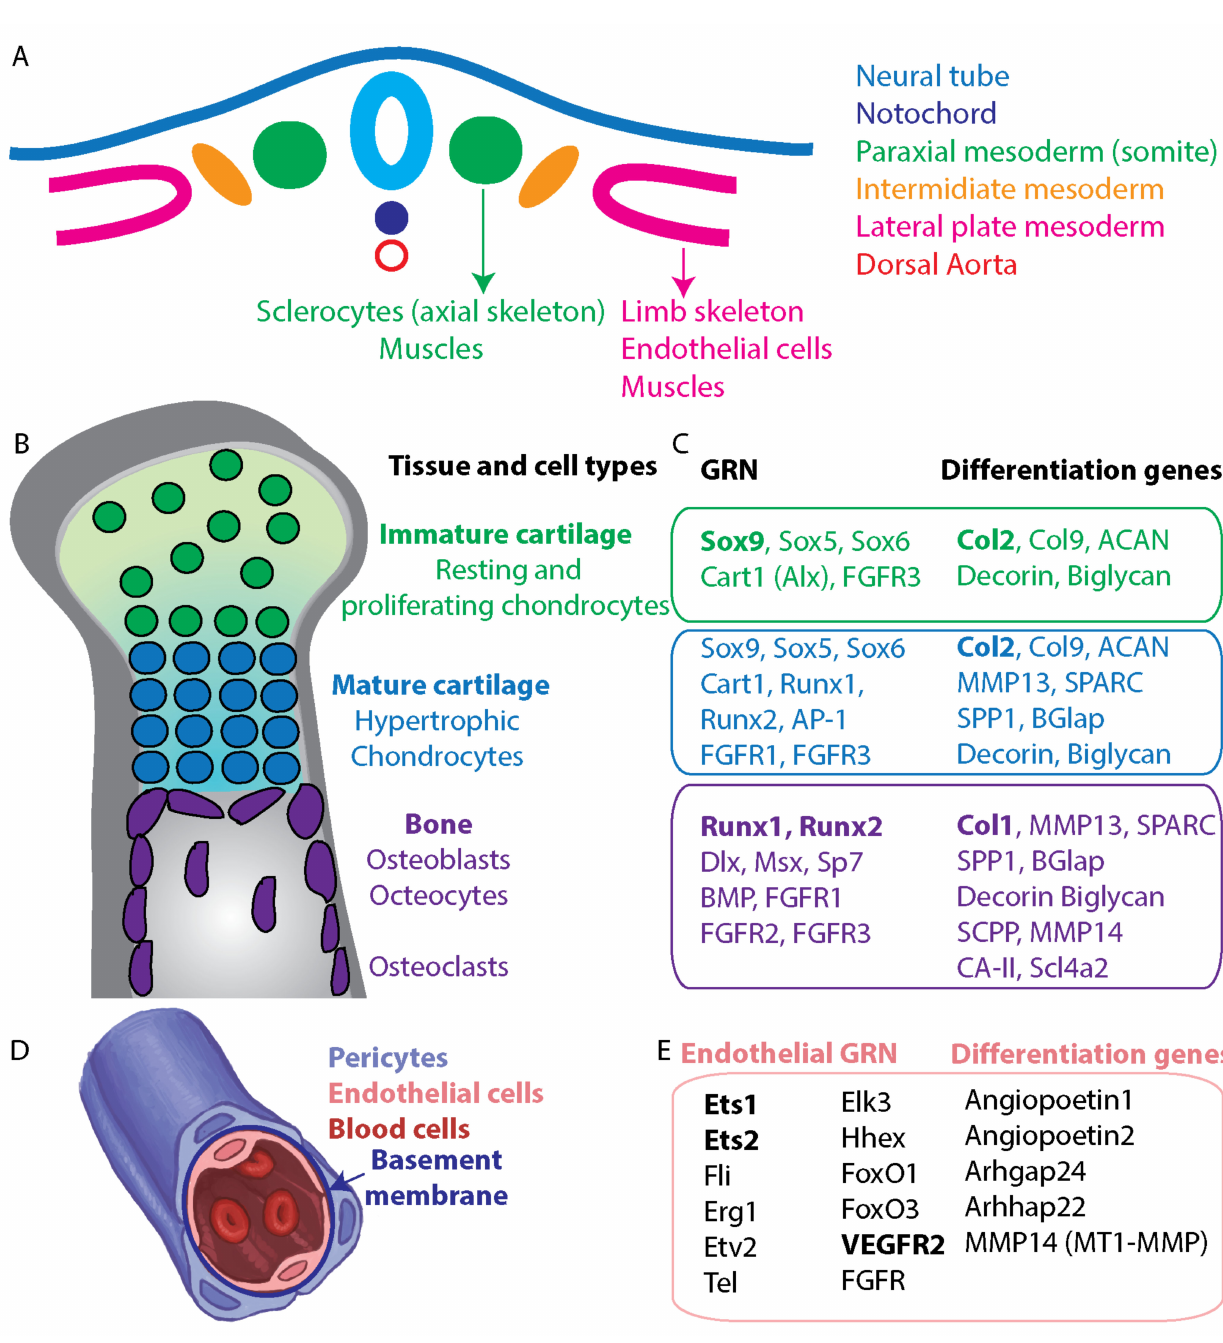
Figure 4. Bone biomineralization and vascular tubulogenesis GRNs in vertebrates. ( A ), schematic diagram showing a cross section of the dorsal part of a vertebrate embryo and the different embryonic territories that contribute to skeletal and vascular tissues. ( B ), tissues and cell types that participate in endochondral ossification in vertebrates. Immature cartilage (green) is generated by proliferating and resting chondrocytes. Mature cartilage (blue) is generated by hypertrophic chondrocytes, bone matrix and mineralization (gray) are generated by osteoblasts, maintained by osteocytes and reabsorbed by osteoclasts (purple). ( C ), GRN and differentiation genes in the different bone forming cells. Color code matches the territories and cells in ( B , D ), schematic diagram of vertebrate blood vessel showing the different cell types that constitute it. Blood cells occupy the lumen which is engulfed by endothelial cells. The endothelial cells are bound to the basement membrane from the inner side of the vessel and pericytes from the outside. Image courtesy of Yarden Ben-Tabou de-Leon (artist). ( E ), endothelial cell GRN and differentiation